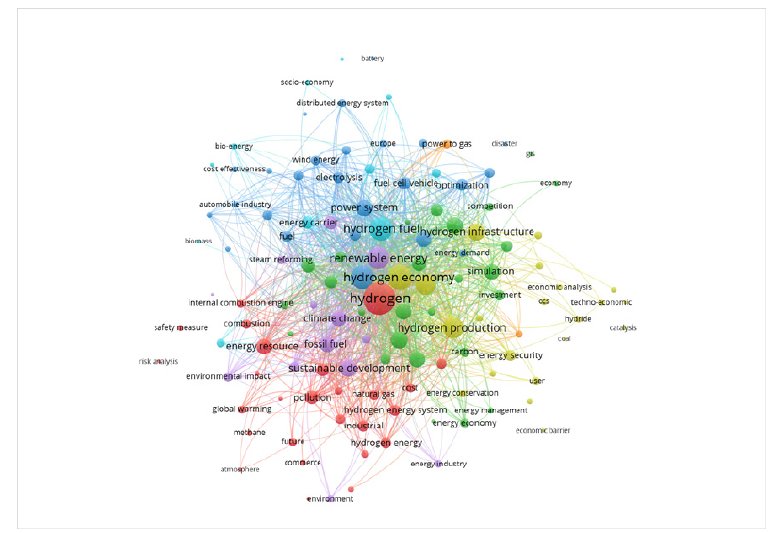
Figure 6. Keyword network map for 2010 to 2019.